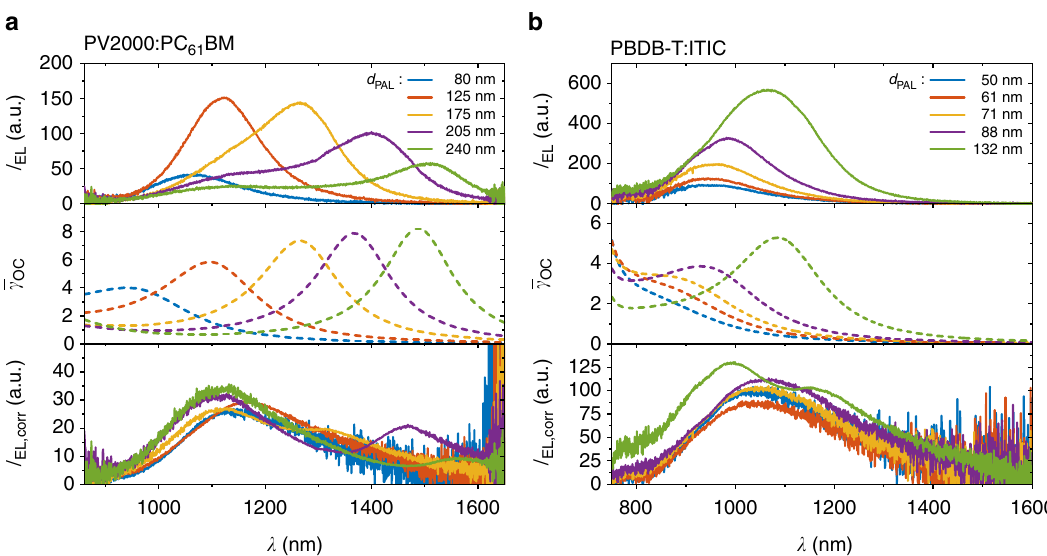
Fig. 5 Electroluminescence spectra for PV2000:PC 61 BM and PBDB-T:ITIC solar cells. EL spectra I EL ( λ ) of PV2000:PC 61 BM solar cells ( a ) and PBDB-T:ITIC solar cells ( b ) for different thicknesses d PAL of the photoactive layer in an ITO-based design (type D in Fig. 1), the calculated radiant out-coupling factors (cid:1) γ for the corresponding layer stacks and the spectra corrected for OC